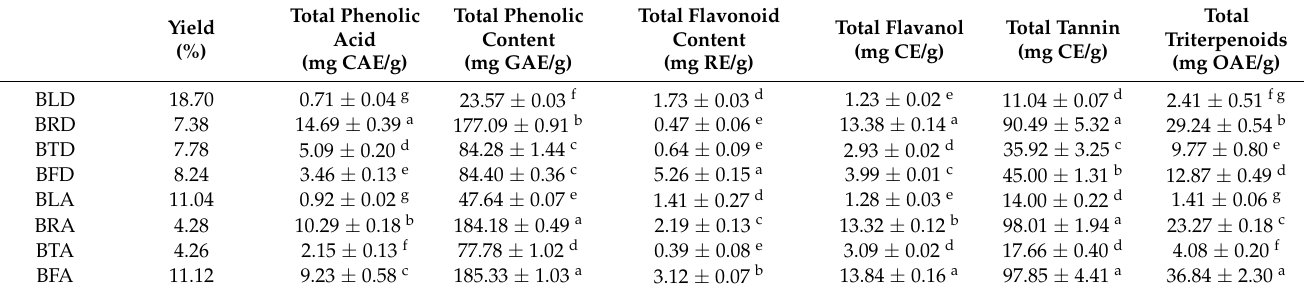
Table 1. Extraction yield (%) and total bioactive components of B. gymnorhiza extracts.